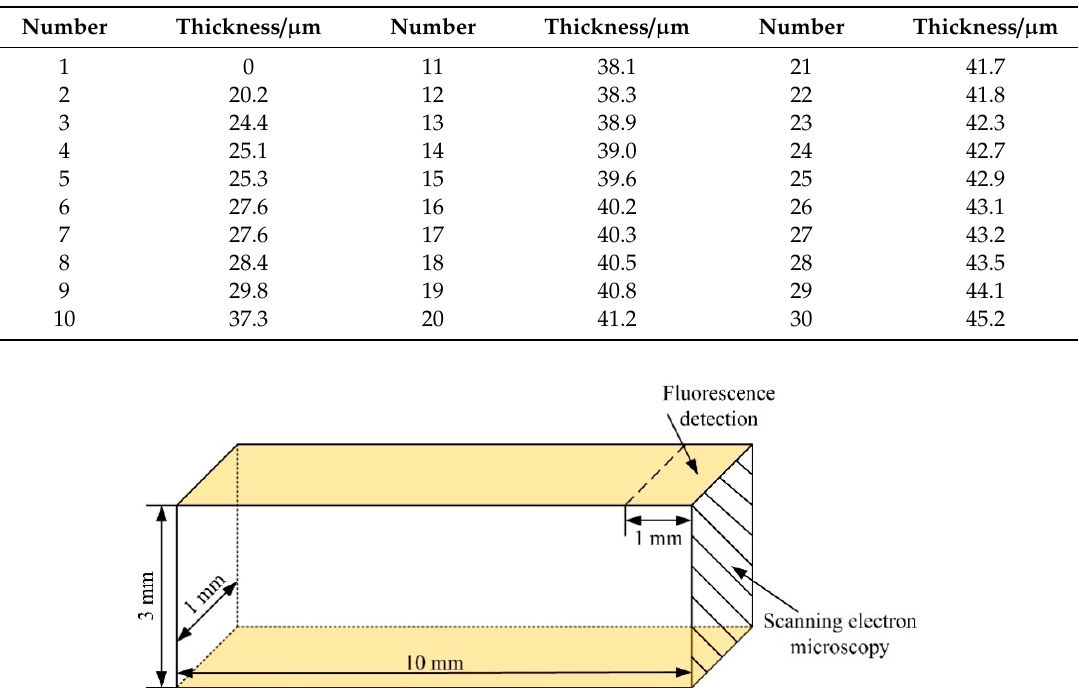
Table 2. Samples with different thicknesses and their numbers.